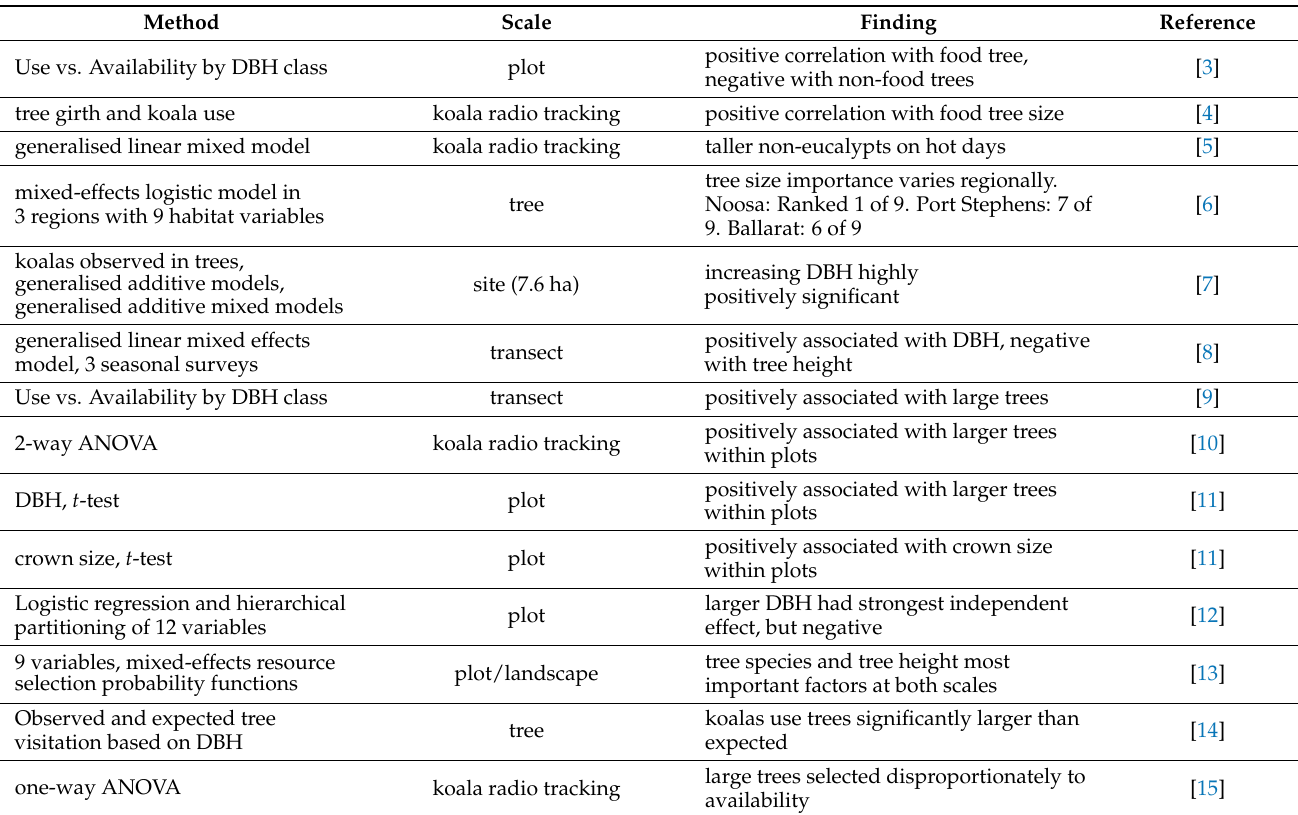
Table 1. Previous studies investigating use of larger trees by the koala. DBH = diameter at breast